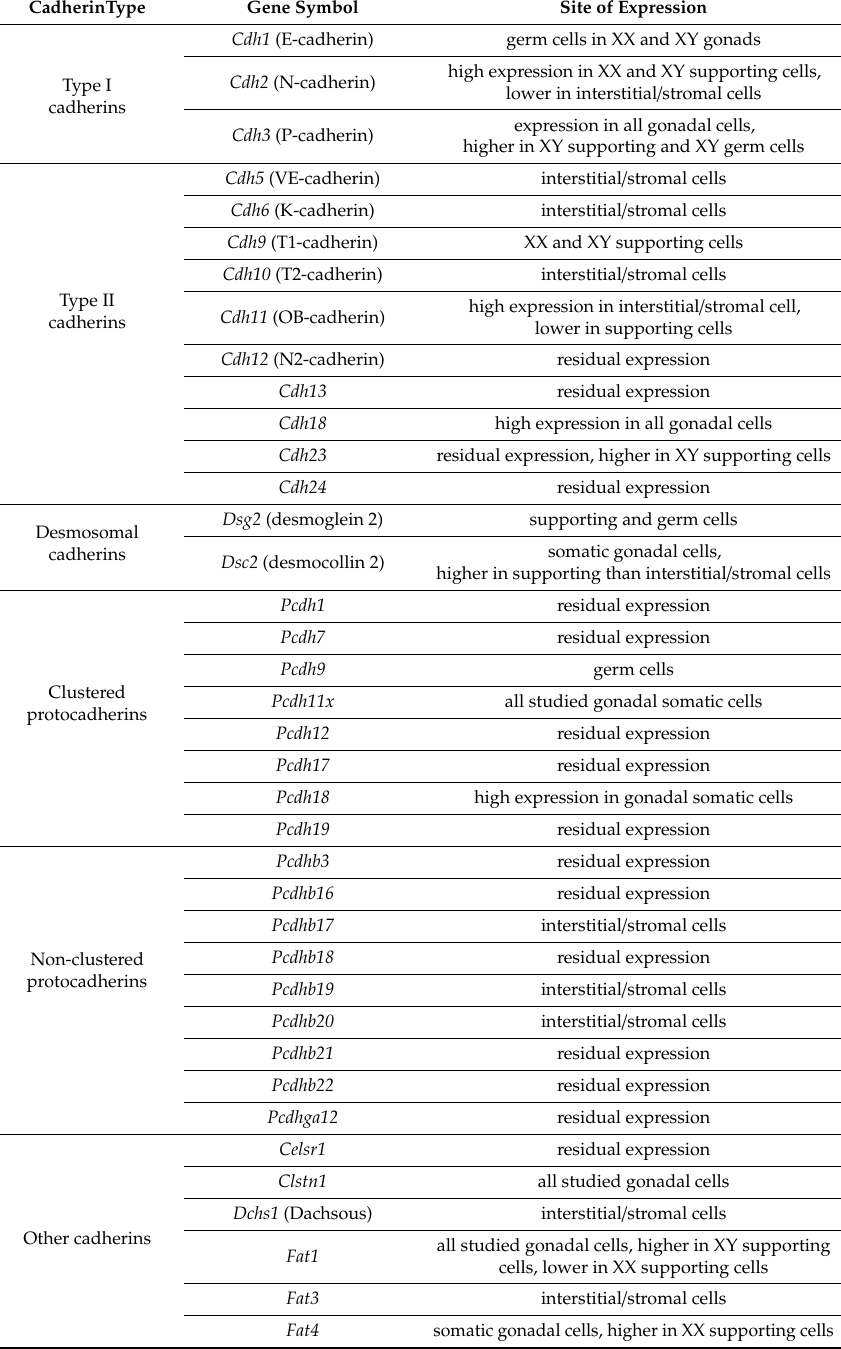
Table 2. Expression of cadherins in sexually di ff erentiating developing mouse gonads (between E11.0 and E13.8) (according to [33]). Expression was studied in XX and XY supporting cells, XX stromal cell, XY interstitial cells, and XX and XY germ cells isolated from the